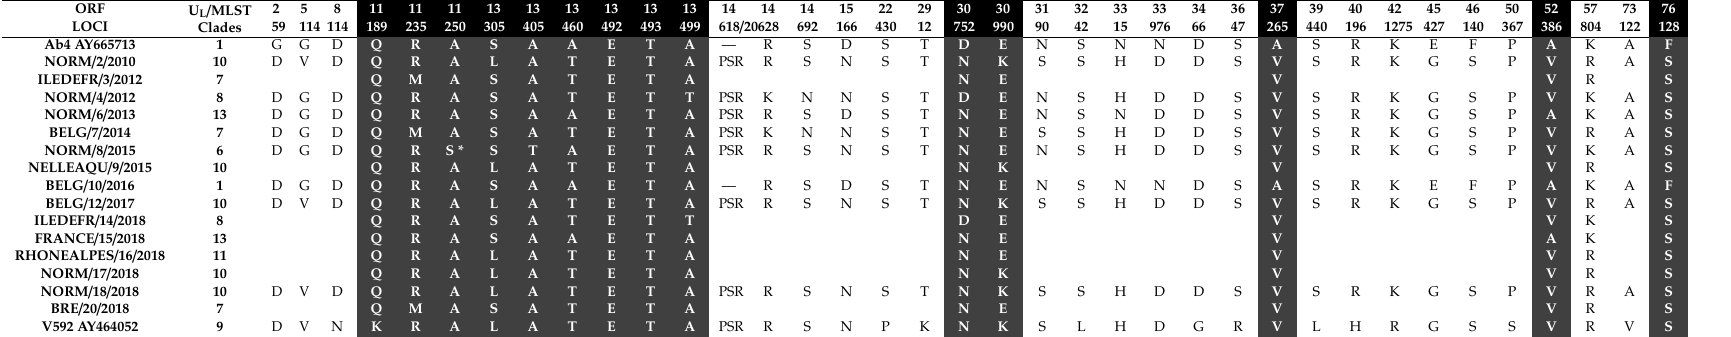
Table 6. Multi Locus Sequence Typing of 15 EHV-1 strains collected from 2010 to 2018. Determinant loci for clade identification are shaded in grey. Ab4 and V292 are included as reference